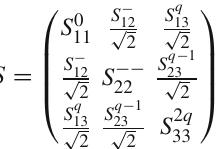
98 GeV, as appropriate. Further, the contributions to (cid:17) m 2 depend only on the mass splitting δ m , nearly insensitive to m 1 . For clarity, the 1 σ , 2 σ , and 3 σ ranges of the measured W mass are also shown (in cyans). Last, but not least, it is clear that m 1 ∼ λ φ − H v 2 /δ m